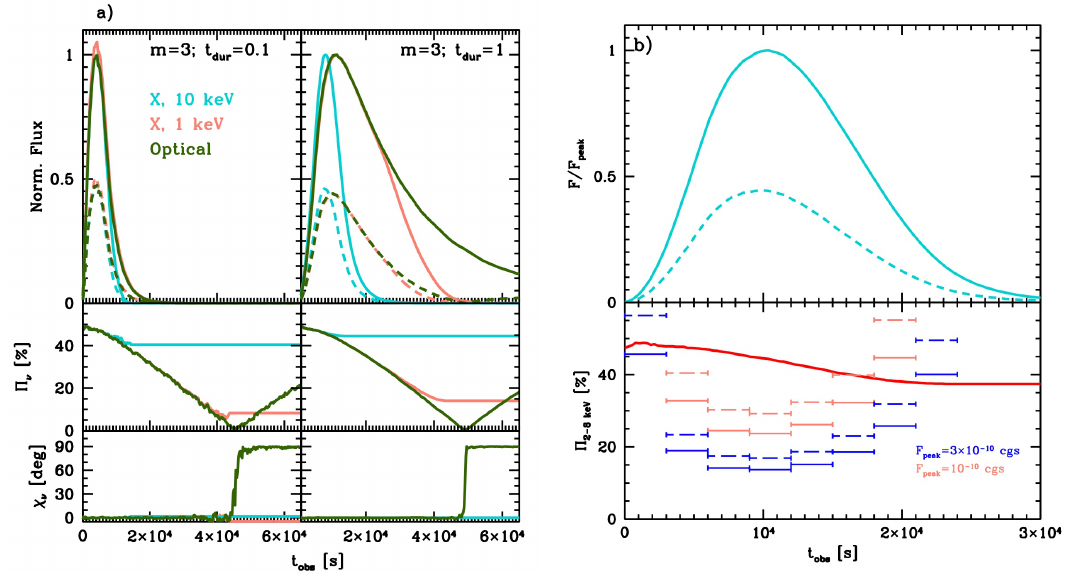
Figure 5. ( a ) Upper panel: normalized light curves at 10 keV (light blue), 1 keV (orange), and in the optical band (green) assuming m = 3 and an injection (rest frame) timescale t dur = 0.1 × r / c (left) and t dur = r / c (right), where r = 10 15 cm is the assumed jet radius. The dashed line shows the polarized flux. Middle panel: the degree of polarization in the three bands. Lower panel: polarization angle in the three bands. All of the quantities are expressed in the observer frame. ( b ) Lightcurve (upper panel) and degree of polarization (lower panel) in the IXPE band (2–8 keV) for the case m = 3 and t dur = r / c . In the lower panel we show the minimum detectable polarization (MDP) at 99% confidence for exposures of 1 ksec, for two peak fluxes and spectral photon index (1.5, solid; 3, dashed). From [33]. Reproduced with kind permission from Oxford University Press and the Royal Astronomical